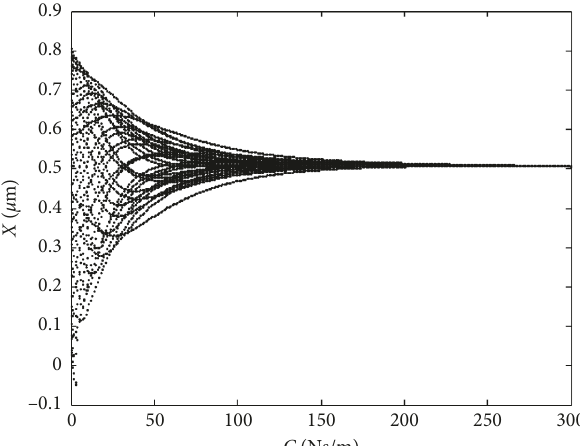
Figure 10: Bifurcation diagram with C as parameter.